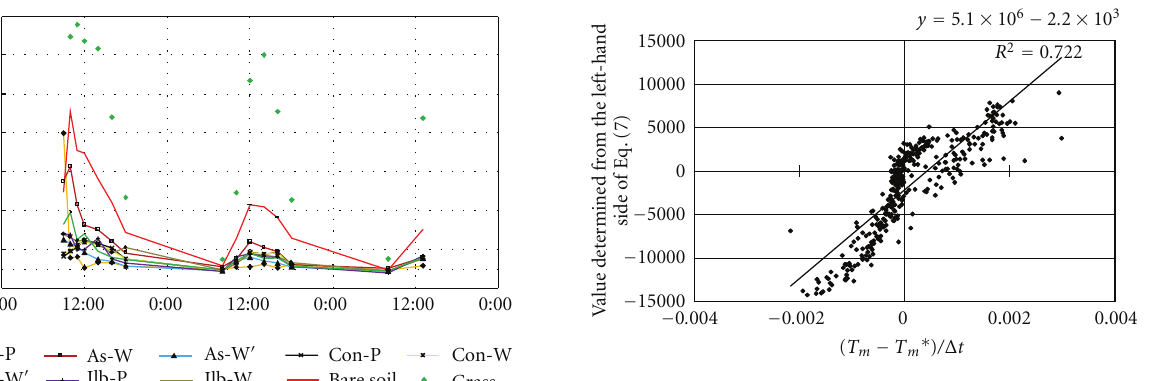
Figure 8: Values of evaporative flux estimated from the observed weights on August 3 to 5, 2005.